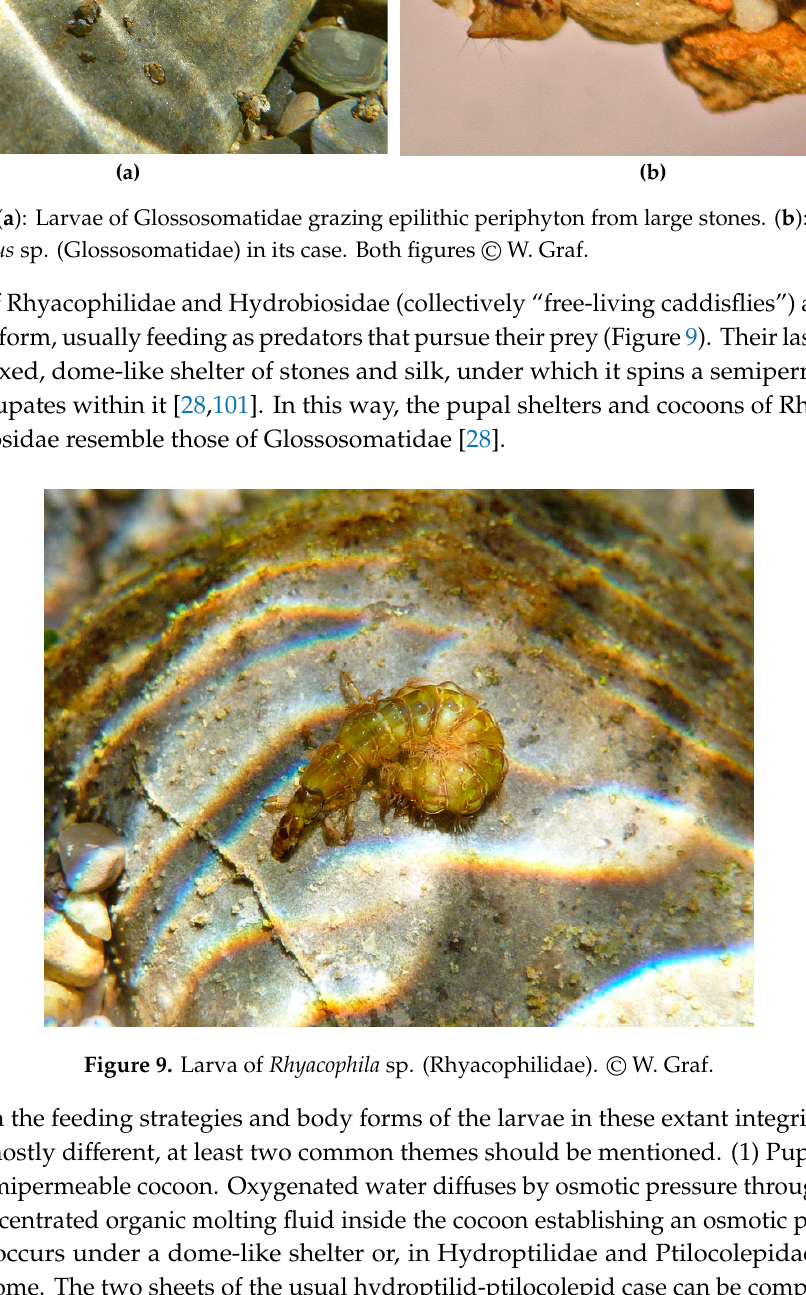
Figure 8. (a) : Larvae of Glossosomatidae grazing epilithic periphyton from large stones. (b) : Larva of